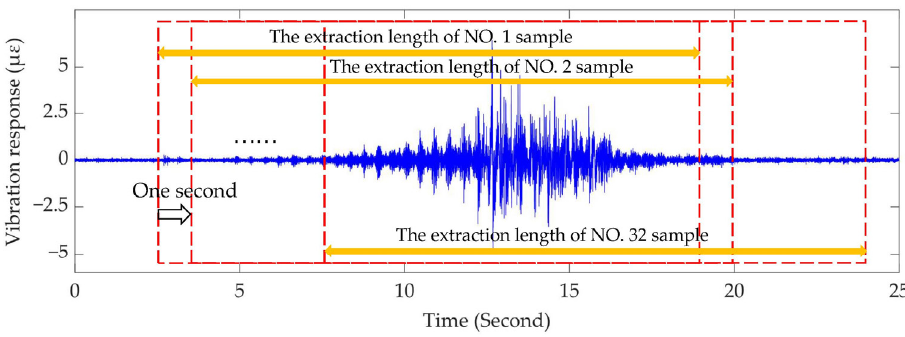
Figure 4. Data augmentation strategy for monitoring area #160 under fastener loose state.